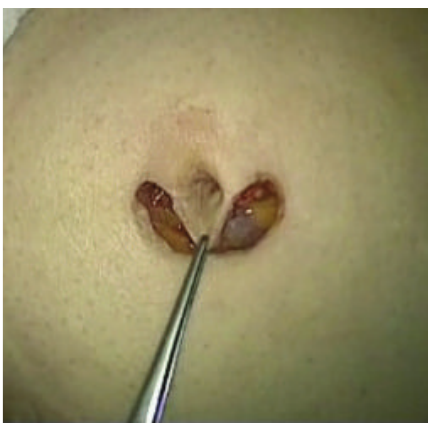
Figure 8: Appearance of the umbilical incision after the